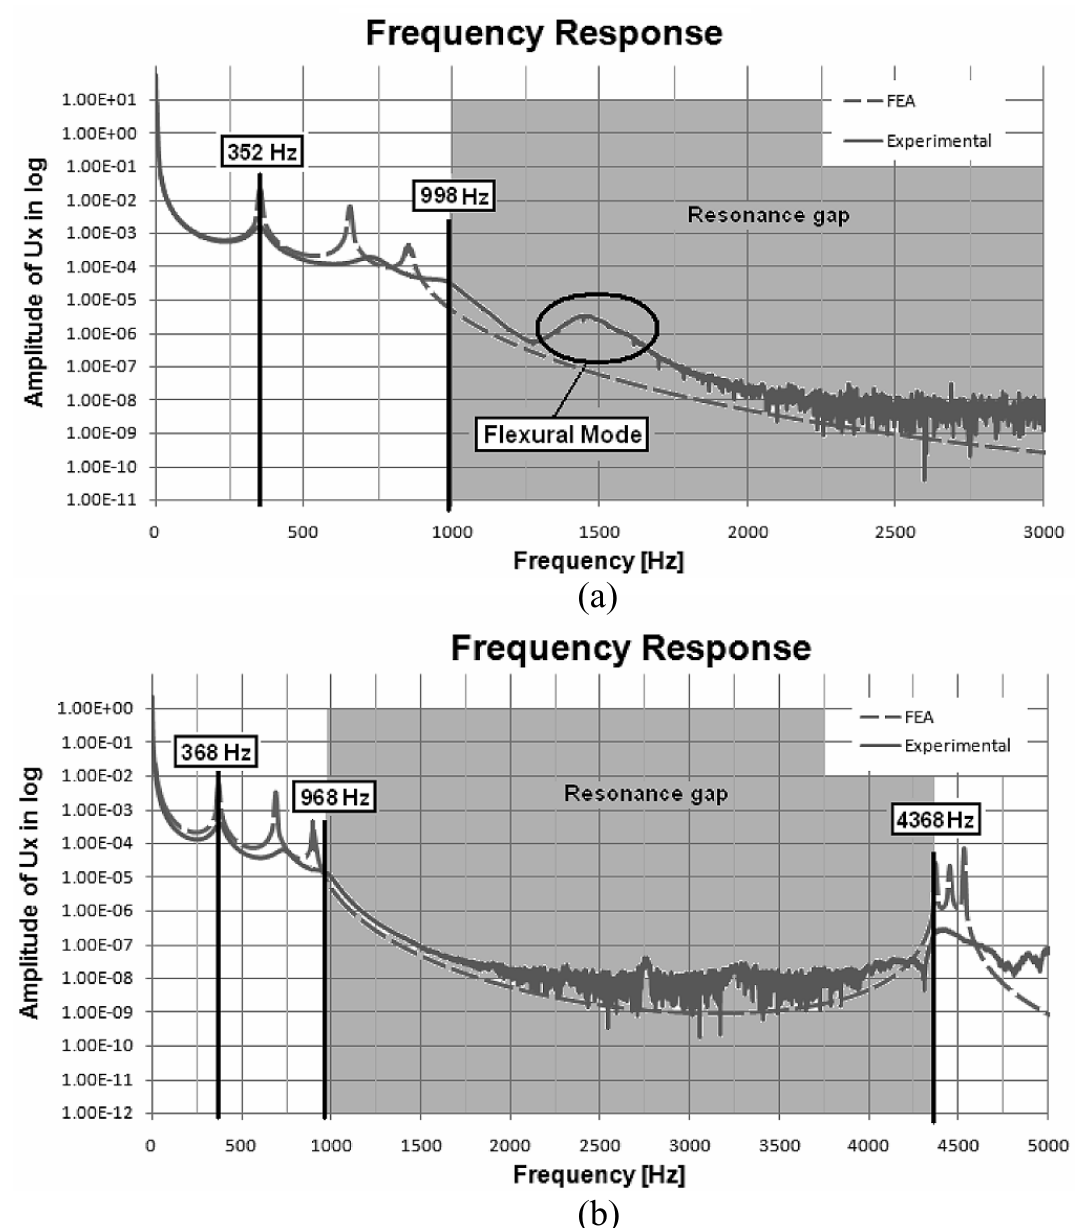
Fig. 8. Frequency response curves: a) steel-commercial cork agglomerate specimen; b) steel-cork agglomerate (ref. 8123 [27])